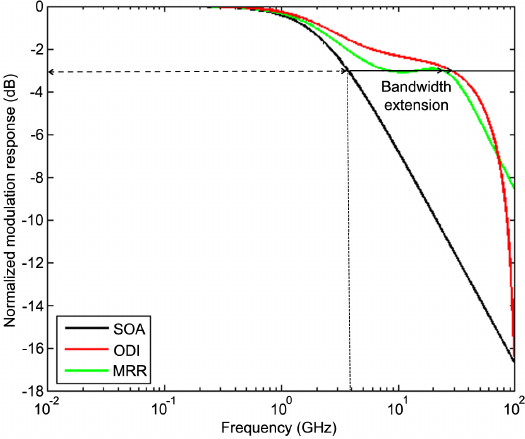
Figure 6. Small-signal modulation response of SOA alone (black color) and with the assistance of ODI (red color) or MRR (green color). The dashed line denotes the 3-dB bandwidth level and the arrows the bandwidth extension achieved by the notch